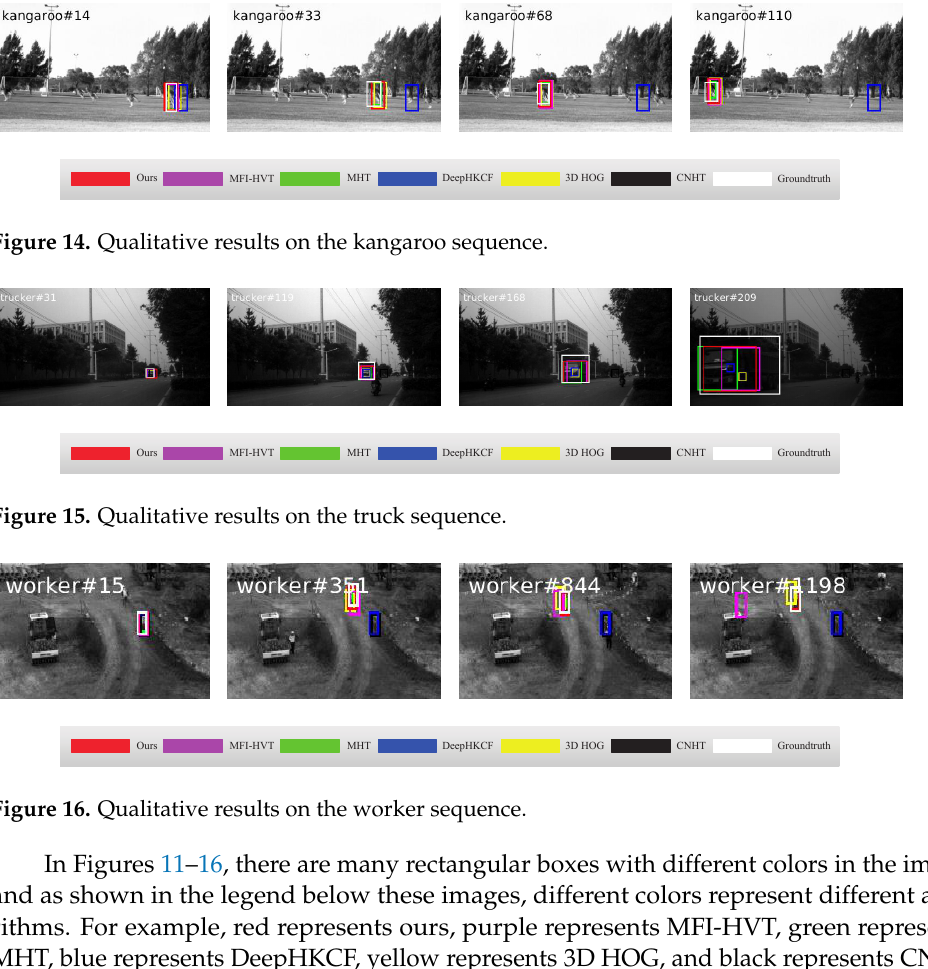
Figure 13. Qualitative results on the car sequence.